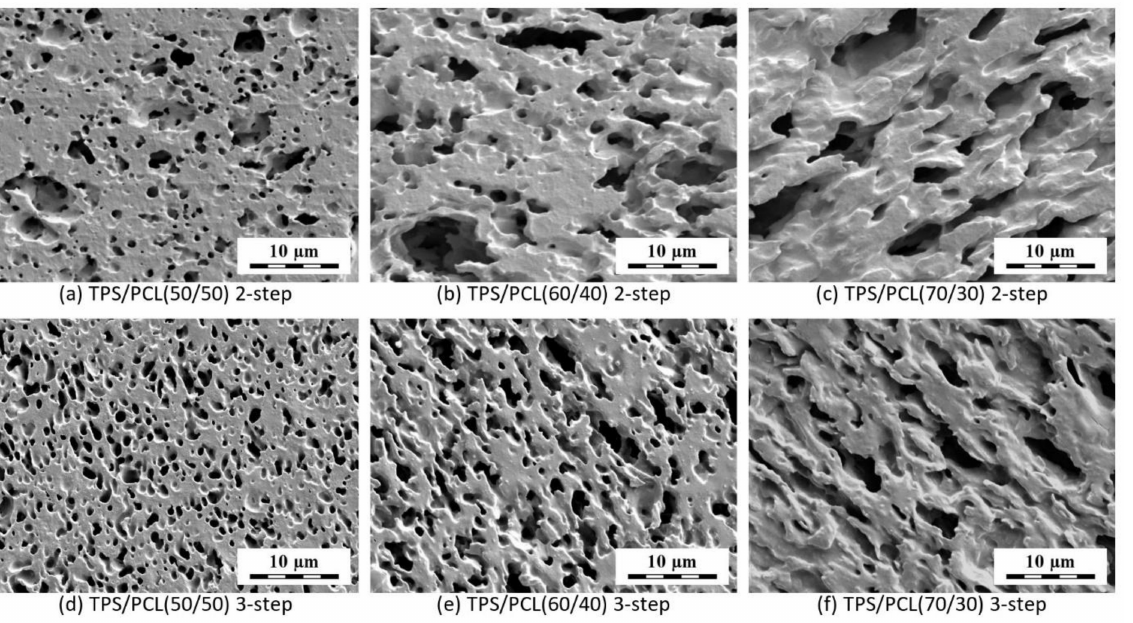
Figure A2. SEM micrographs showing smoothed and etched surfaces of selected TPS/PCL blends prepared by two-step preparation procedure (upper row) and three-step preparation procedure (lower